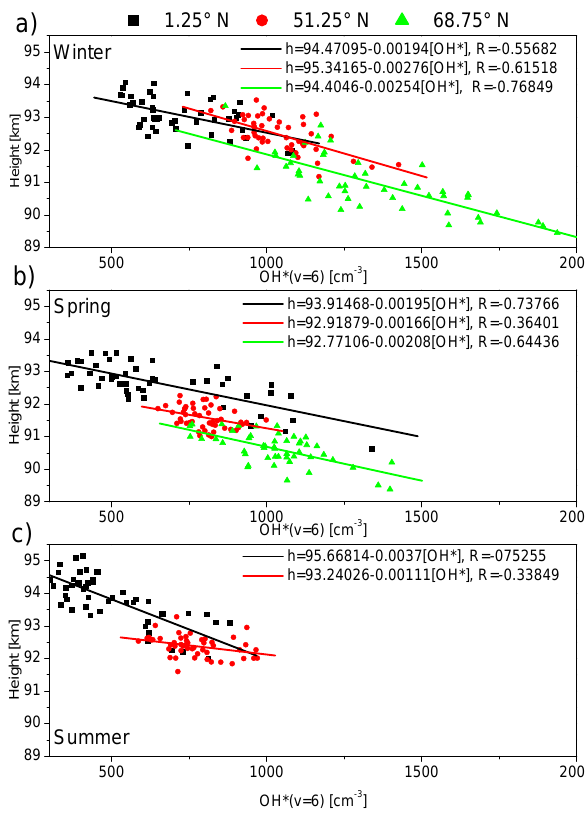
Figure 8. OH ∗ peak height in pressure coordinates versus the OH ∗ density for different seasons. The latitudes are indicated by color.